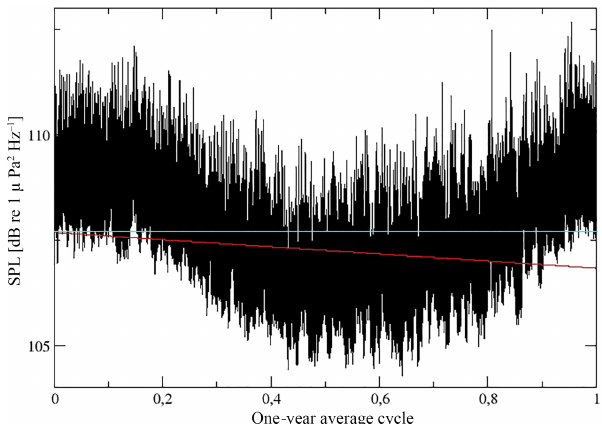
Figure 3. Average annual cycle of the SPL broadband, its linear regression line (red) and horizontal line (cyan) for